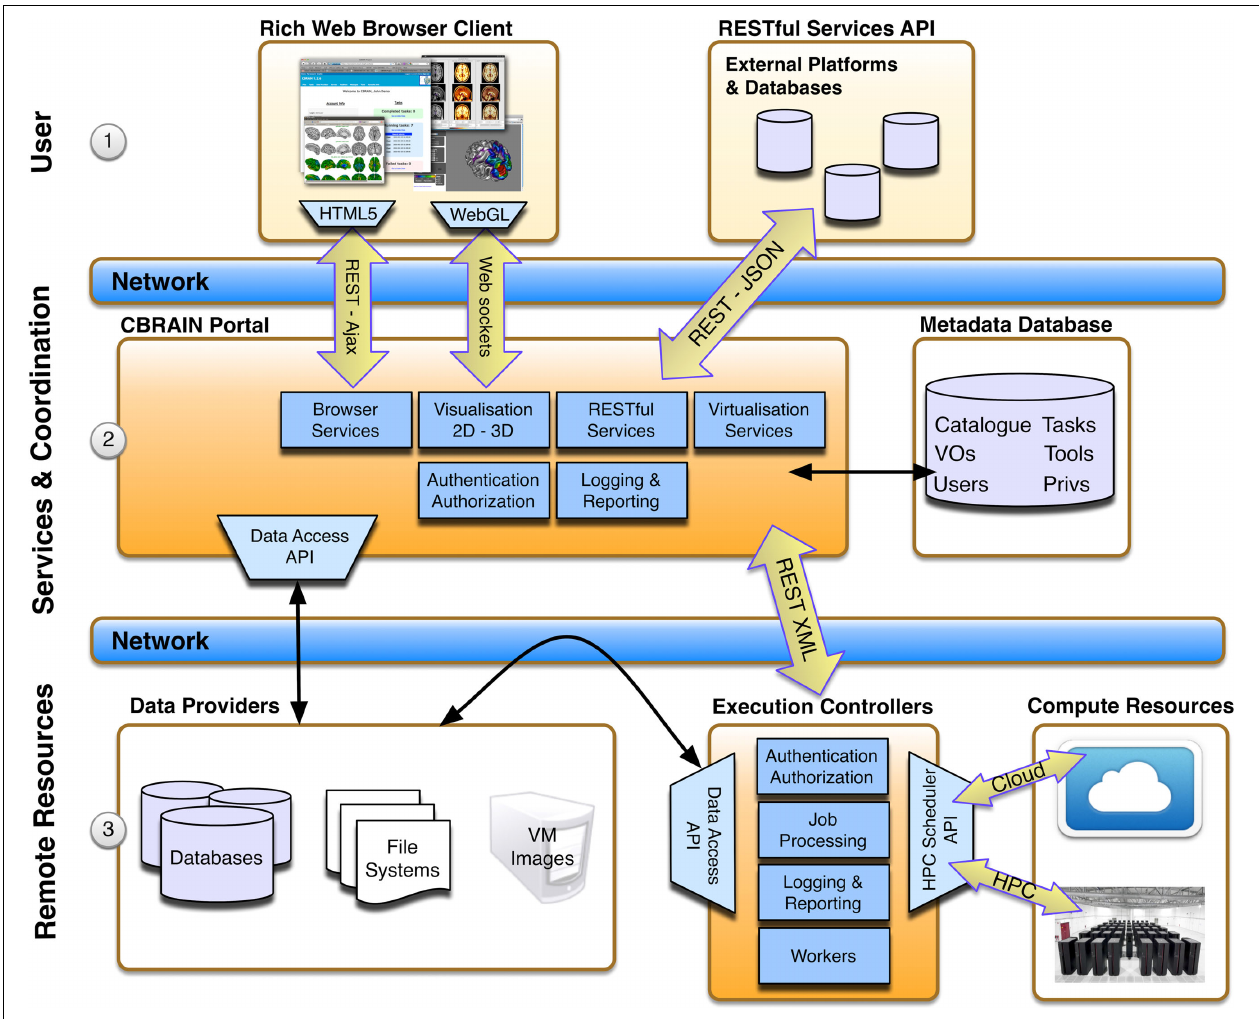
FIGURE 1 | CBRAIN architectural layers. The top user layer (1) represents consumption of services through web browser clients or RESTful API. The central services and coordination layer (2) hosts CBRAIN portals that are responsible for providing services and business logic for requests from the top user layer and orchestration for the lower resource layer. The state of all model instances (users, VOs, tools, resources, catalog, privileges, etc.) is stored in the metadata database. In